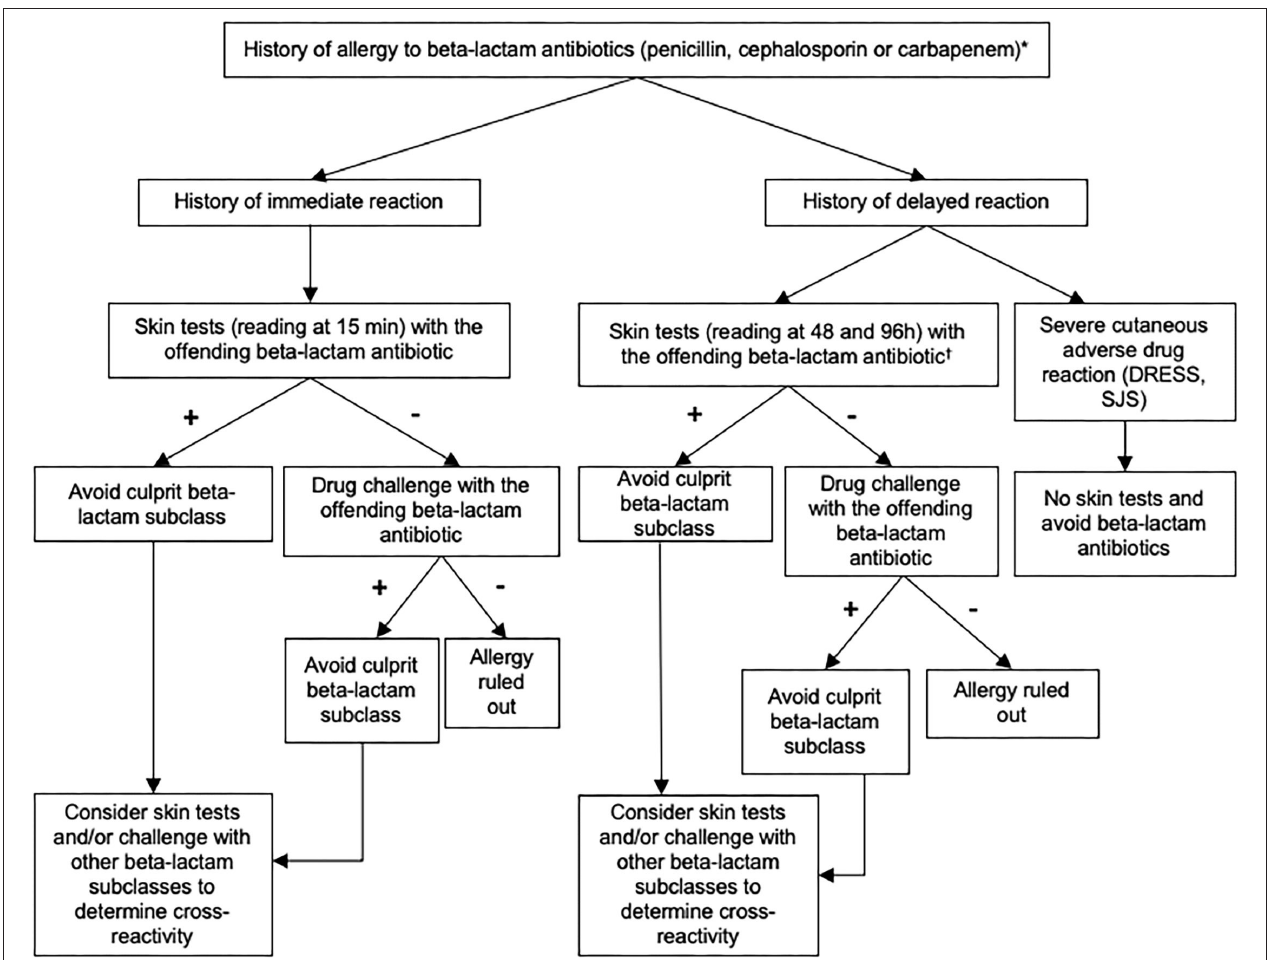
( Figure 1 ). This algorithm is based on clinical history, skin testing [prick tests and intradermal reactions (IDR)] and drug challenges (oral, intravenous, or intramuscular) (6) and allows to identify patients who are truly allergic and to delabel the allergy to beta-lactam in whom it is not